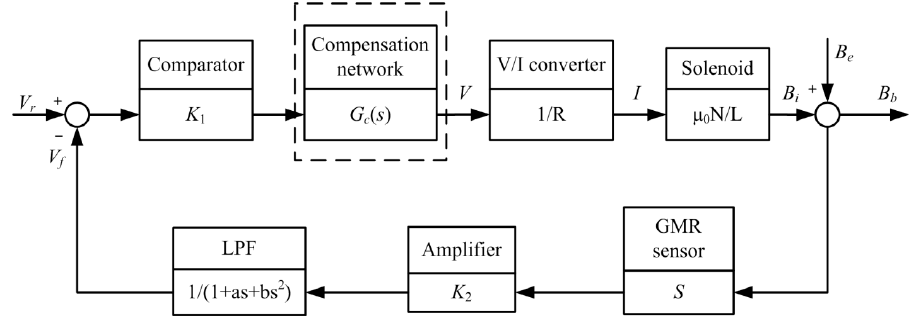
Figure 4. The structure of operating point self-regulator.